Question: Does the figure show an increasing or a decreasing trend?
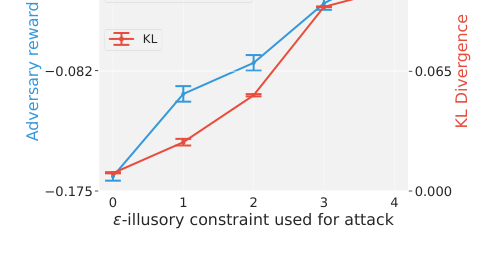
Answer: increasing